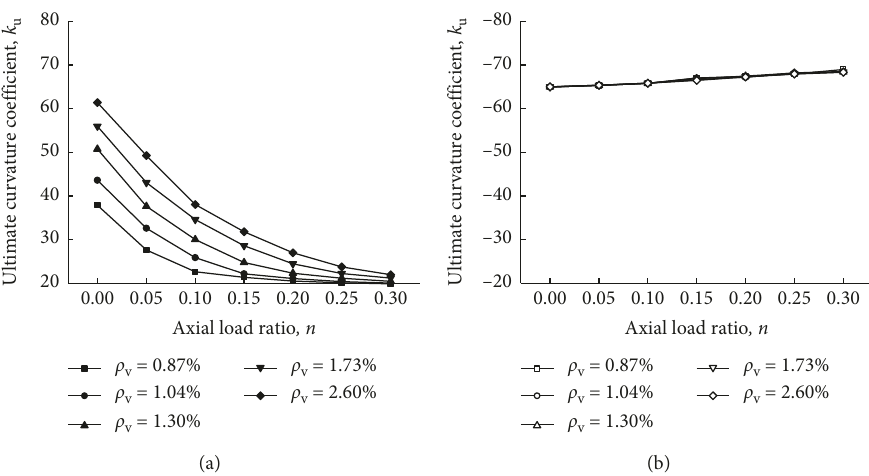
Figure 15: Variations in the ultimate curvature coefficient with the axial load ratio at different transverse reinforcement ratios. (a) Flange in tension. (b) Flange in compression.